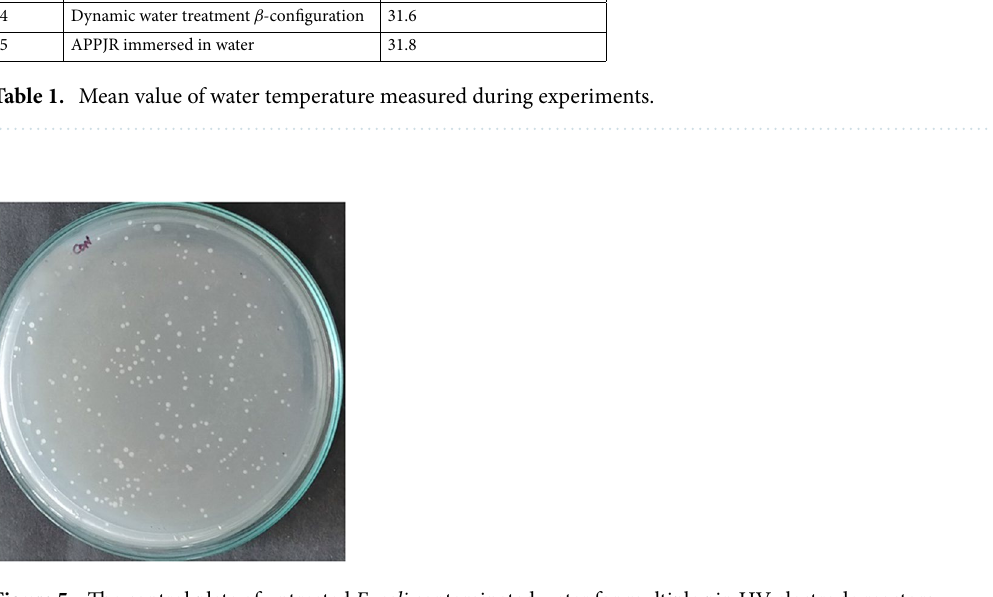
Figure 5. The control plate of untreated E. coli contaminated water for multiple pin HV electrode